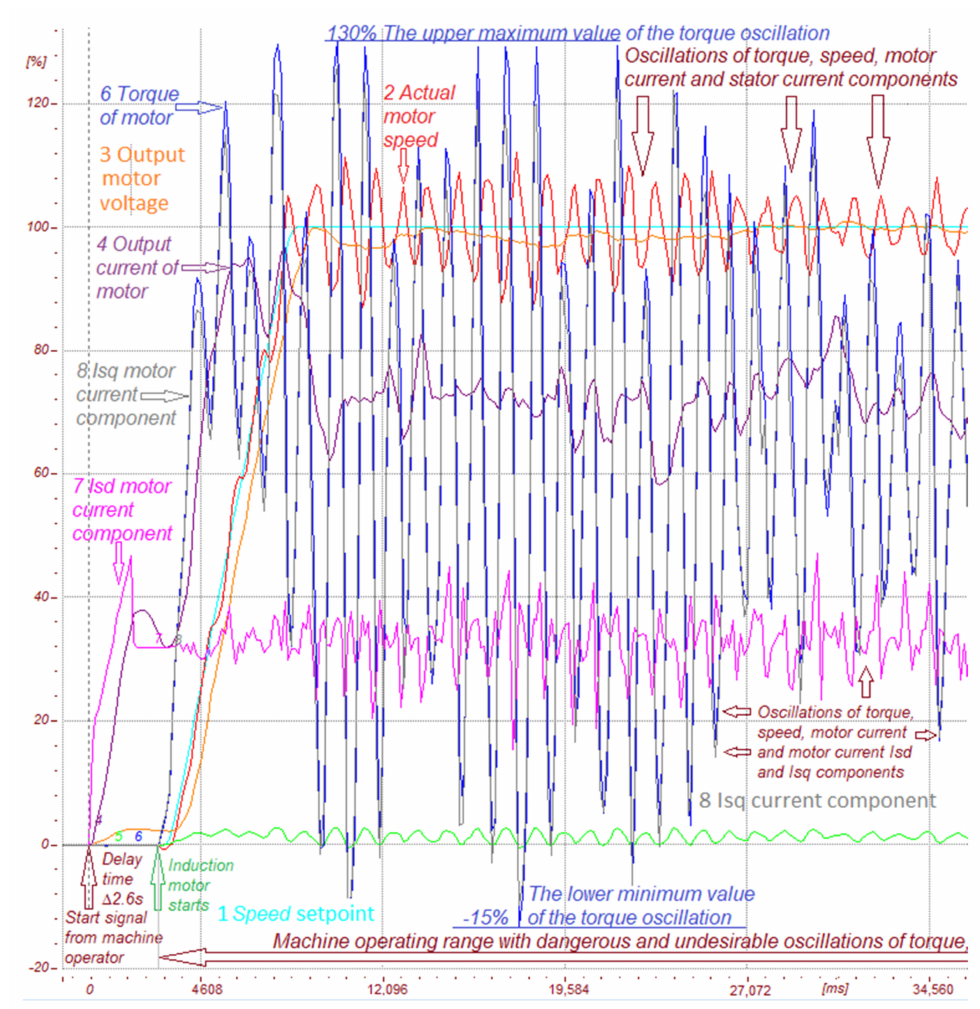
Figure 5. Working characteristics during start-up of the stacker machine with control settings resulting in dangerous